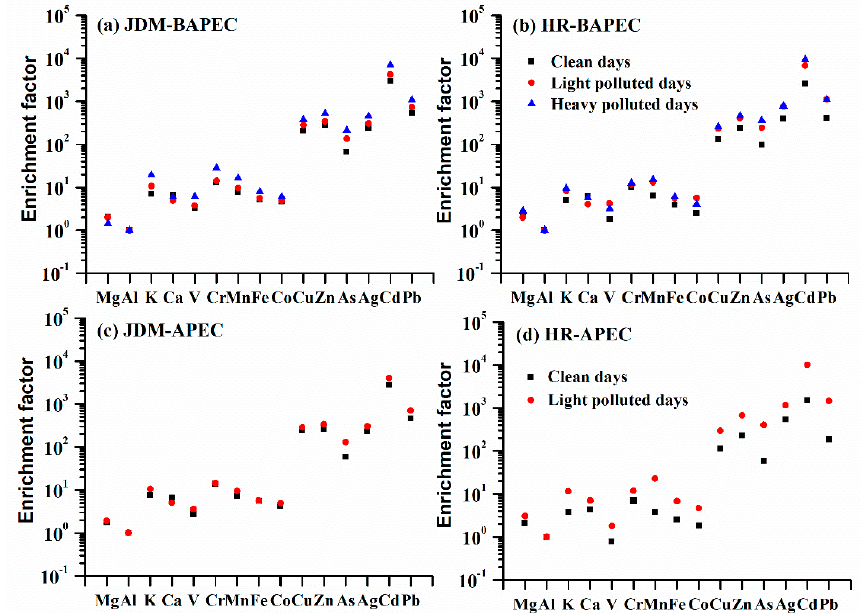
Figure 5. Enrichment factors of metallic elements on clean days, light polluted days and heavy polluted days ( a , b ) before and ( c , d ) during the APEC summit in Beijing urban site (JDM) and suburban site (HR).